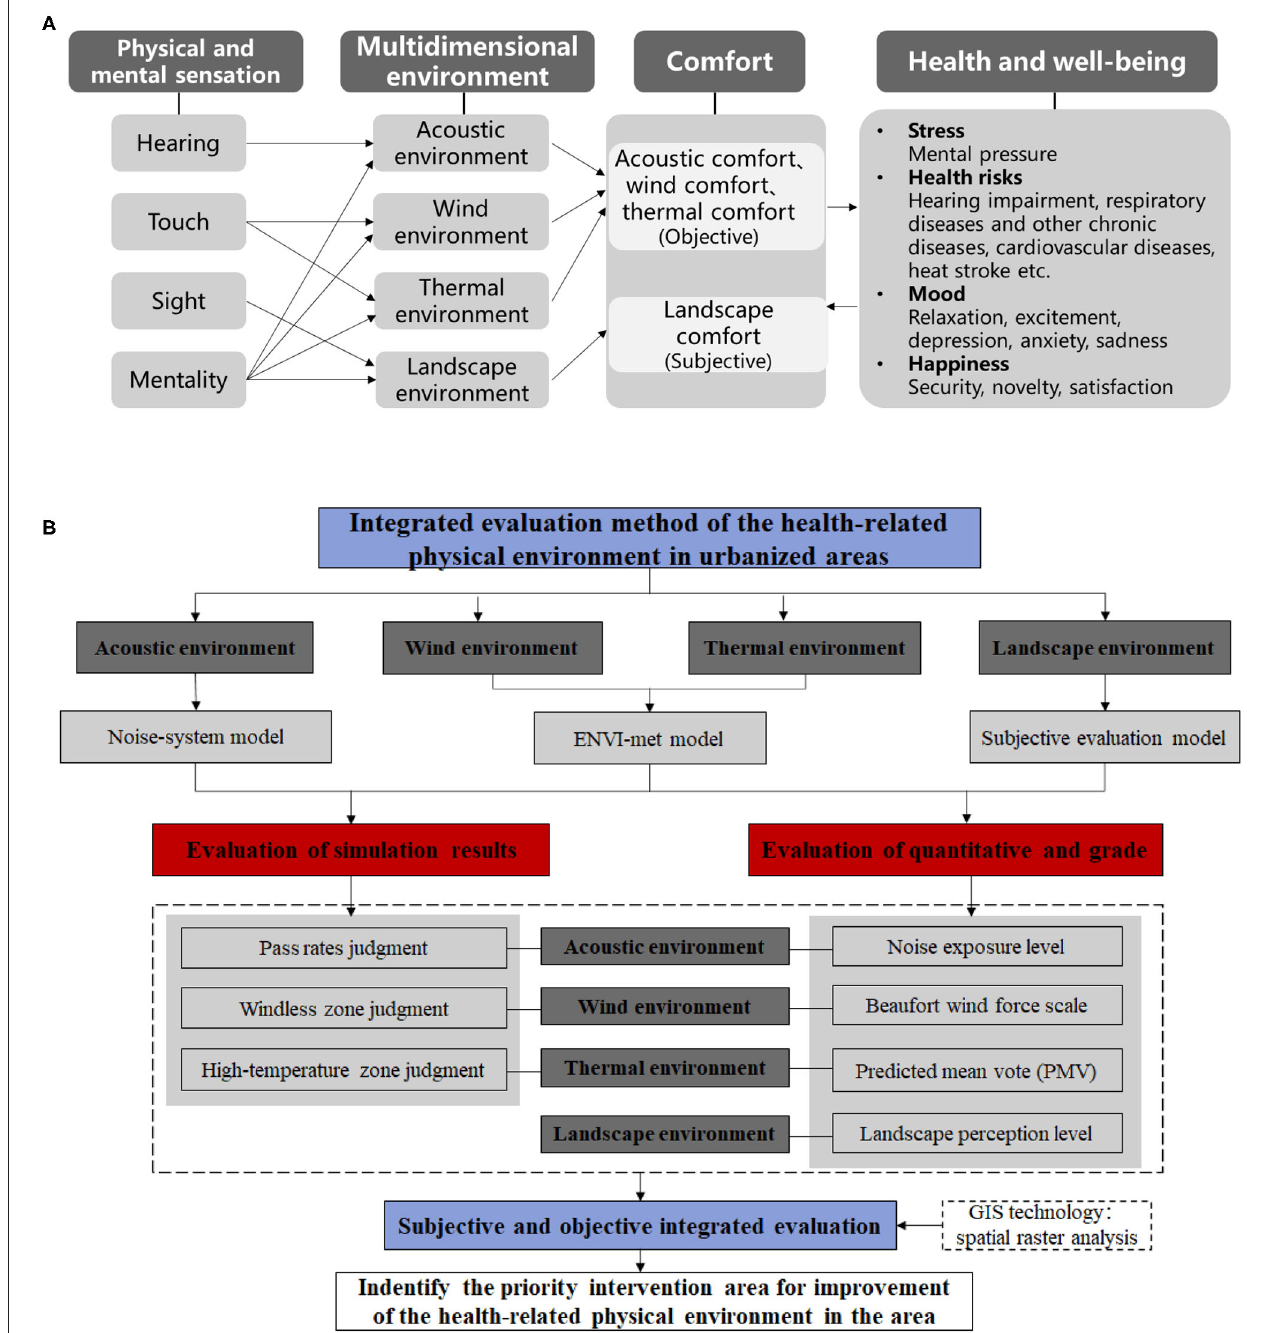
FIGURE 2 | Research framework: (A) conceptual framework for health-related physical environment, (B) technology route.